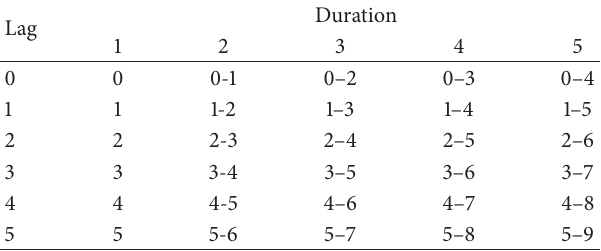
Table 1: The design of temporal patterns (5 time durations × 6 time lags) of precipitation for analyzing the relationship between current NDVI and different combinations of duration and lag precipitation. The numbers in the cells indicated the time interval for which precipitation was accumulated (0 indicated the current 16-day period, 1 indicated the first previous period, 2 indicated the secondpreviousperiod,0-1indicatedprecipitationwasaccumulated from current period to the first previous period, 0–2 indicated precipitation was accumulated from current period to the second previous period,